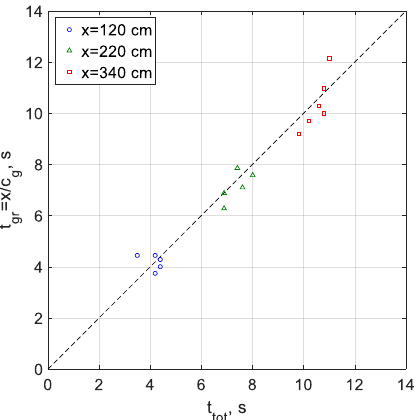
Figure 25. The calculated according to the model duration of the initial wave growth process, t gr , compared to the measured growth duration, t tot .